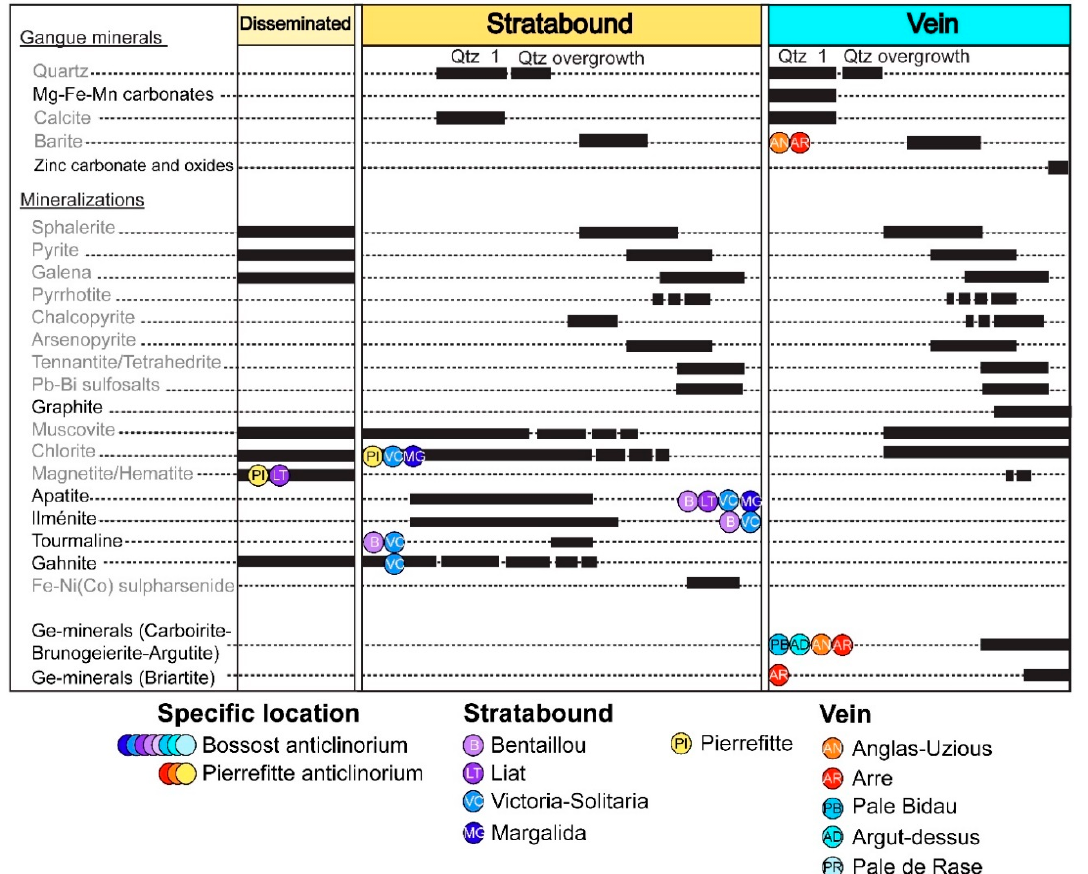
Figure 8. Paragenetic succession of ore and gangue minerals for all the eleven Pyrenean-studied Pb-Zn deposits. Minerals in grey are common to both stratabound and vein mineralizations and minerals in black are only present in stratabound or vein. Minerals only reported in a deposit are noted with the deposit circle. Several minerals like apatite, ilmenite, or tourmaline are only present in stratabound mineralization. Ge-minerals, graphite zinc carbonates or oxides, and Mg-Fe-Mn carbonates are only observed in vein mineralization ( n = 110).